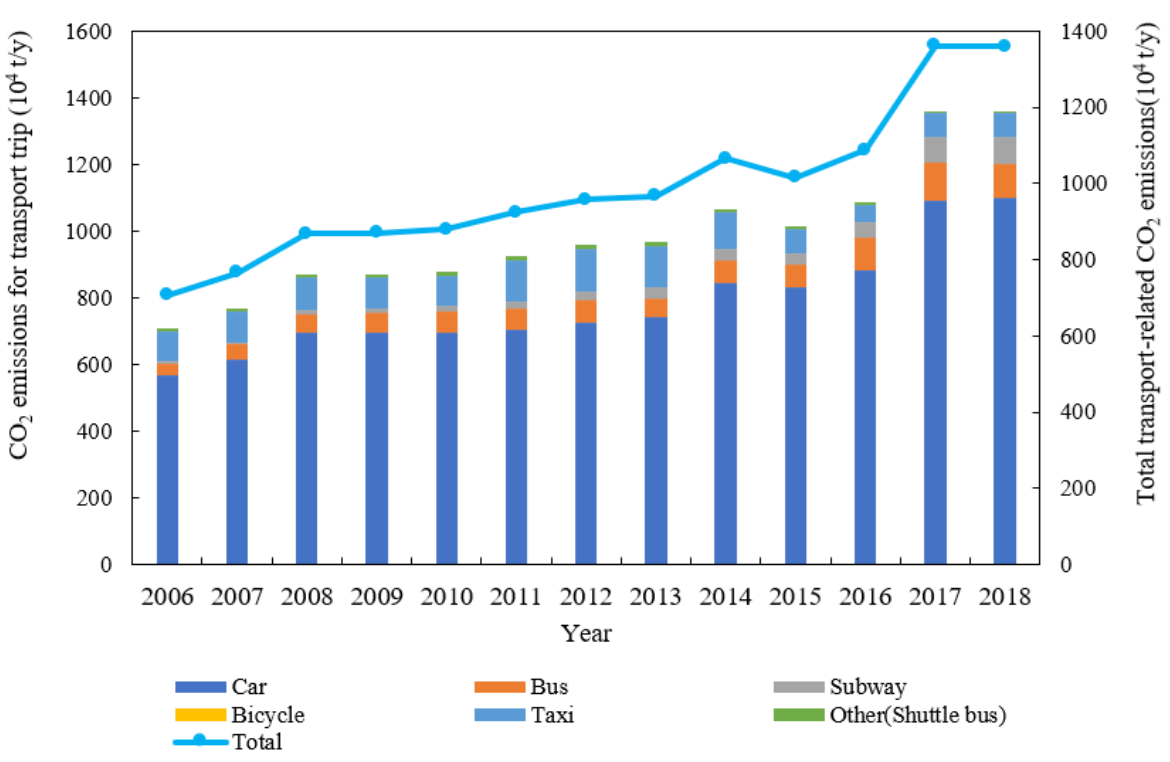
Figure 6. Changes in transport travel structure in Beijing from 2006 to 2018.